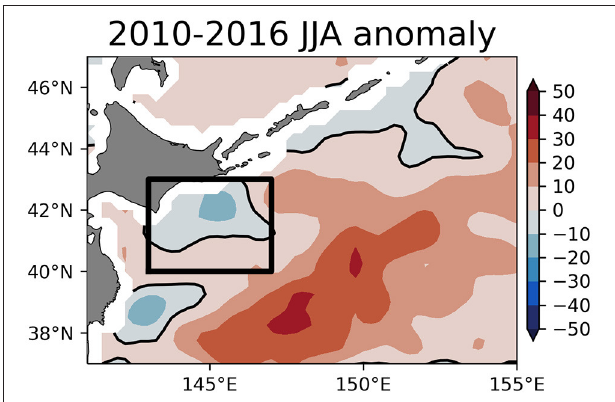
FIGURE 5 | Anomaly of the 2010–2016 average downward net heat flux (color and contour; W m − 2 ) in JJA to the 1993–2009 average in JJA calculated from the ERA5 reanalysis. The box enclosed by the black lines is the same as the previous